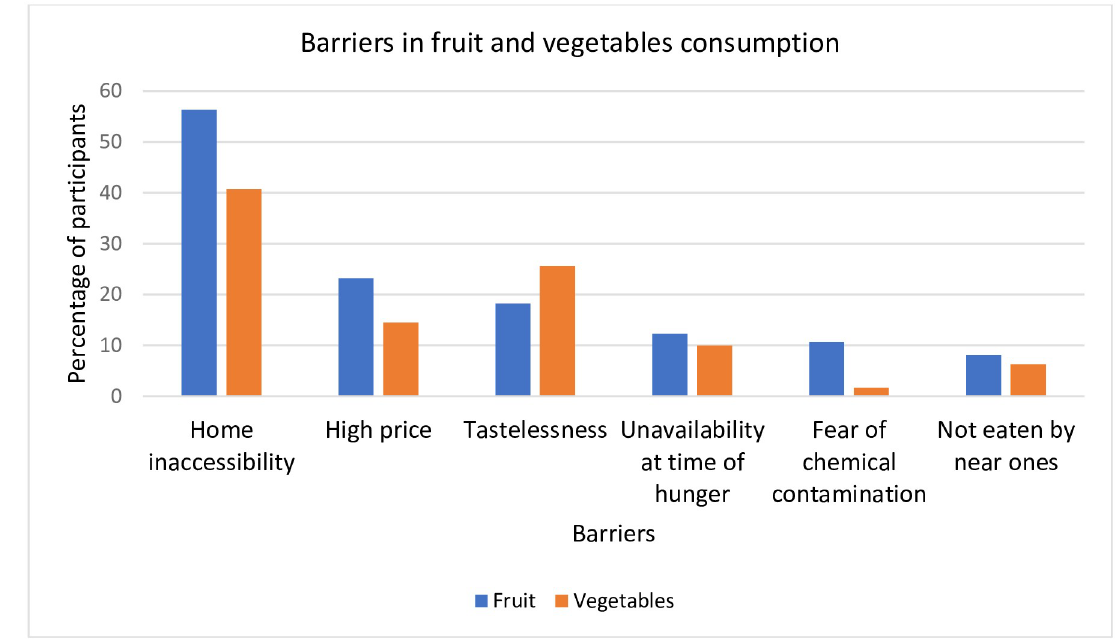
Fig 1. Perceived barriers in fruit and vegetables consumption among participants.